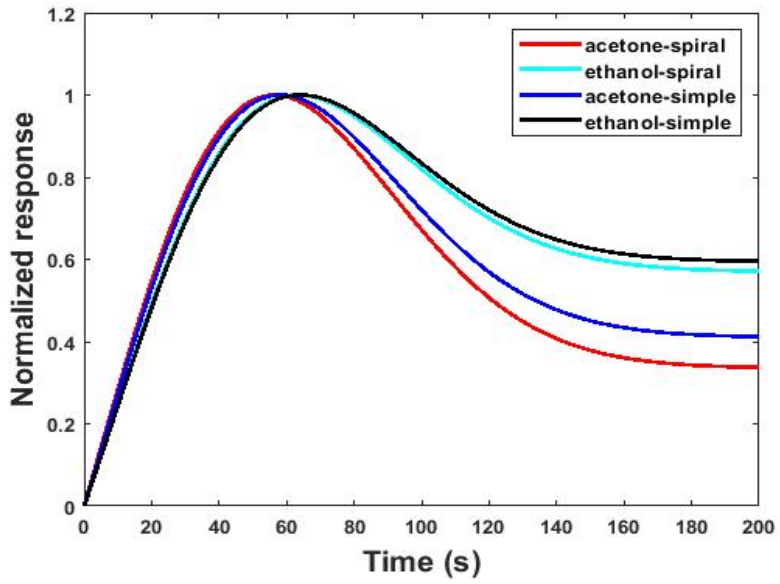
Figure 9. Selectivity of the sensor exposed to 2.6 ppm acetone and ethanol gases in both serpentine and simple models with the same dimensions at a 27 °C working temperature.